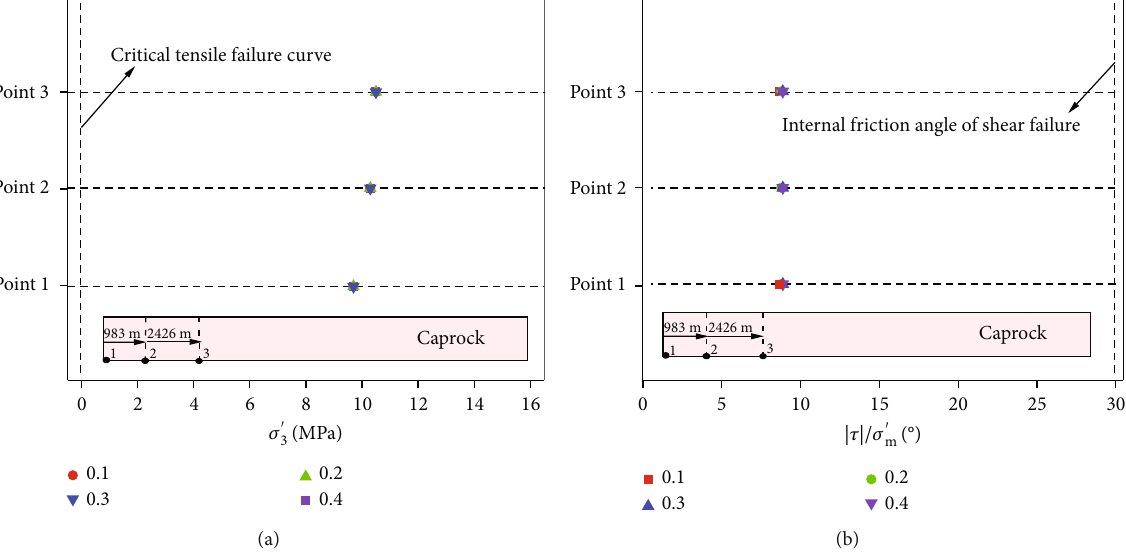
Figure 25: In fl uence of Poisson ’ s ratio of caprock on mechanical integrity of caprock. (a) The minimum principal stress. (b) Critical internal friction